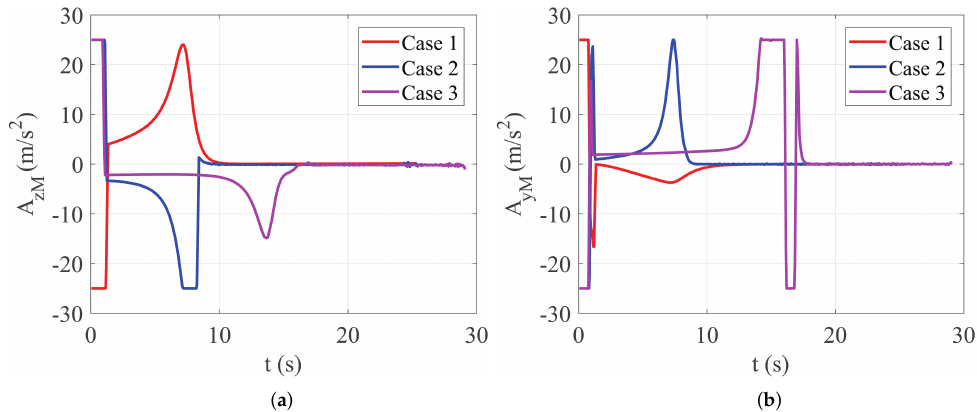
Figure 3. Variations of LOS rates against constant maneuvering targets: ( a ) LOS rates in pitch plane; ( b ) LOS rates in yaw plane.